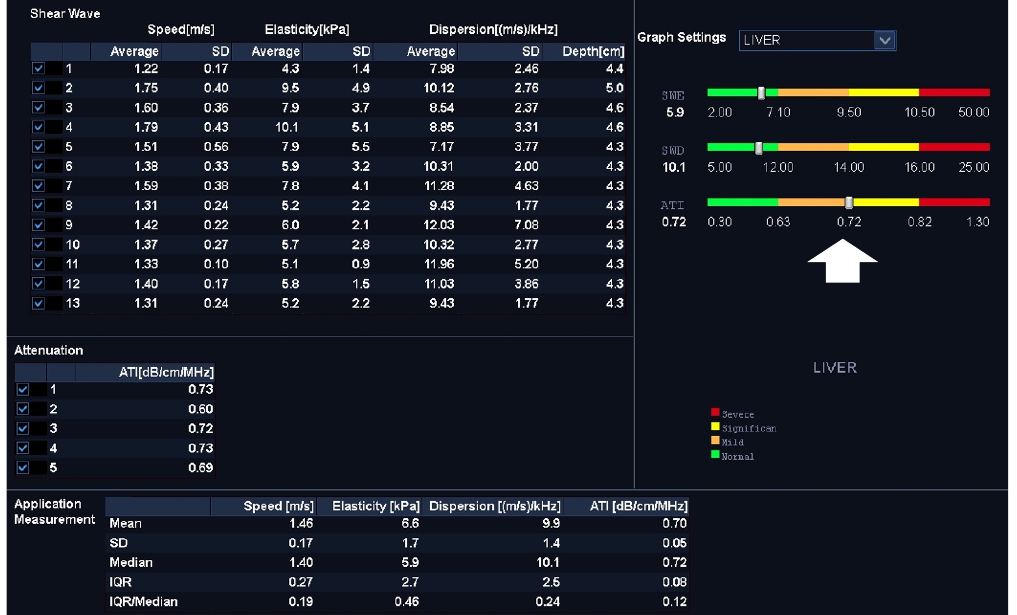
Figure 2. Qualitative and quantitative ATI evaluations after acquisition of 5 ATI cycles (mean 0.7 dB/cm/MHz). The automated, integrated color scale (white thickened arrow) for classification of the patient’s values suggested “mild to significant” changes in ATI analysis, although SWE and SWD measurements were considered “normal”. These findings suggest the presence of significant steatosis with lobular inflammation, but without relevant fibrosis.